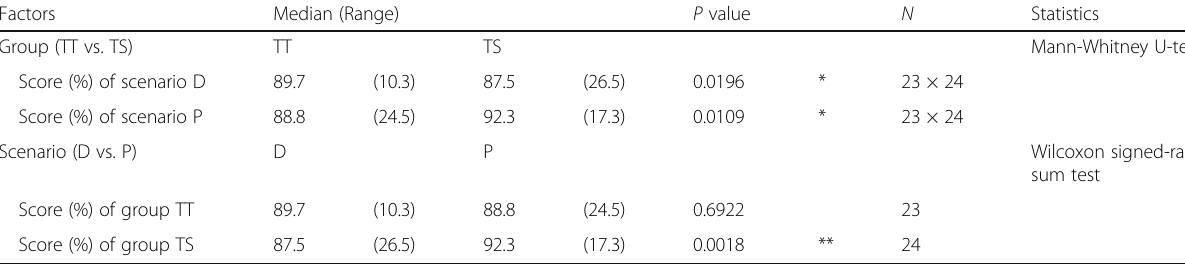
Table 5 Comparison of pedigree scores using f-treeGC with or without